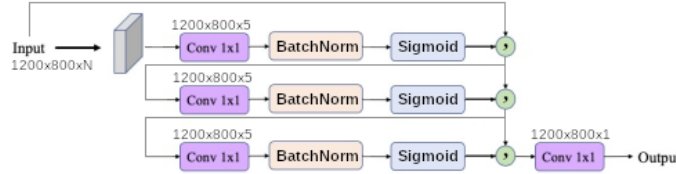
Figure 6. Universal function approximation model (depth = 3, width =